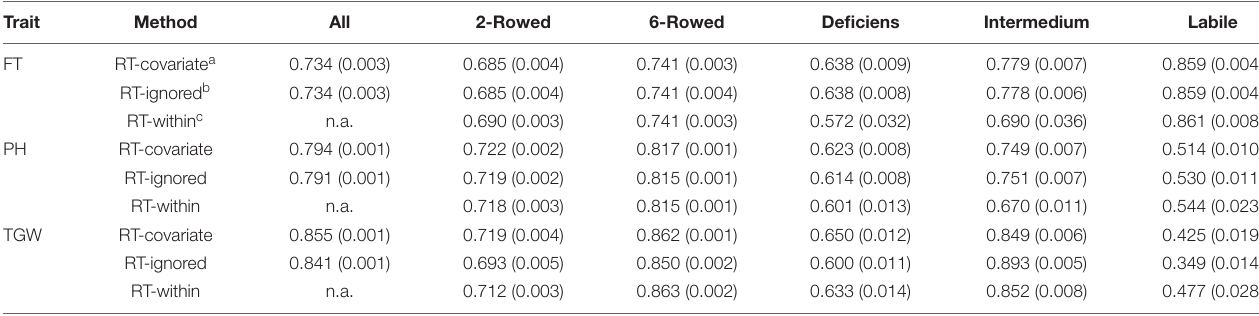
TABLE 4 | Genome-wide prediction abilities of flowering time (FT), plant height (PH), and thousand grain weight (TGW) obtained by applying five-fold cross validation to the entire set of phenotyped spring barley accessions modeling the row type as covariate (RT). Trait